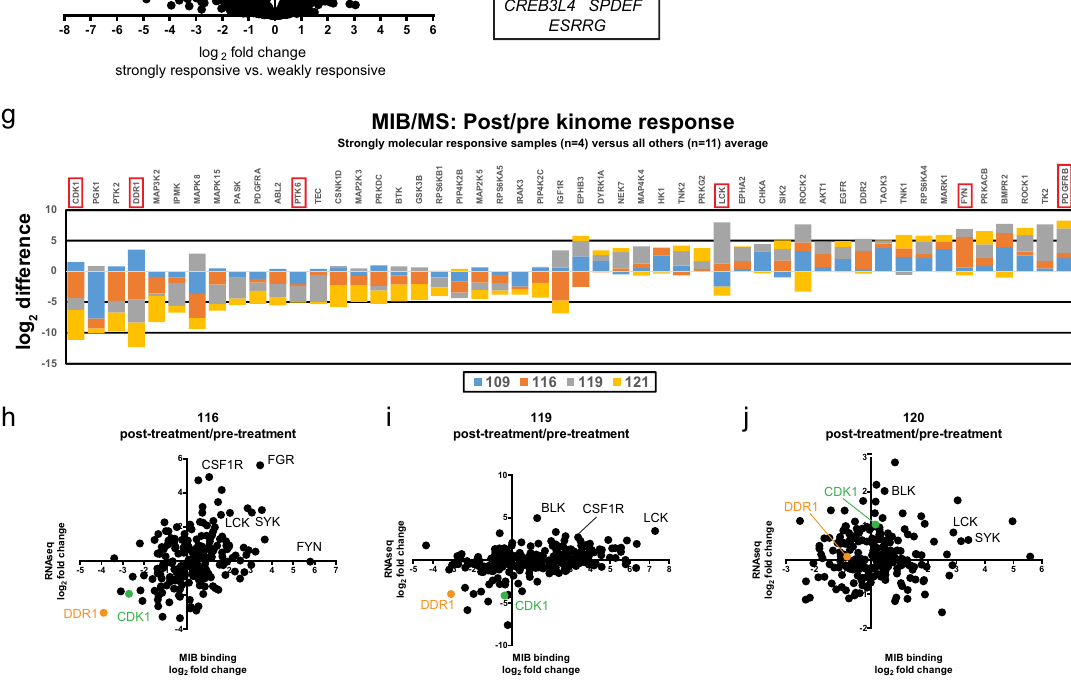
with a similar pro fi le to the 6 tumors identi fi ed in our study. Marker selection analysis on the distinct cluster of 7 tumors versus the remaining 43 was performed and an equivalent comparison was made for our study to highlight any observed similarities (Fig. 5c). Of the top 20 discriminatory kinases with decreased expression, 6 were common to both data sets — HER2, HER3 , PTK6 , DDR1, TRIB3 , and FRK (Fig. 5b, red). As the 03-311 expression analysis utilized Illumina beadchip arrays, multiple gene probes were sometimes present. Notably, all probes for HER3 and PTK6 were included among the top discriminatory markers for 03-311.